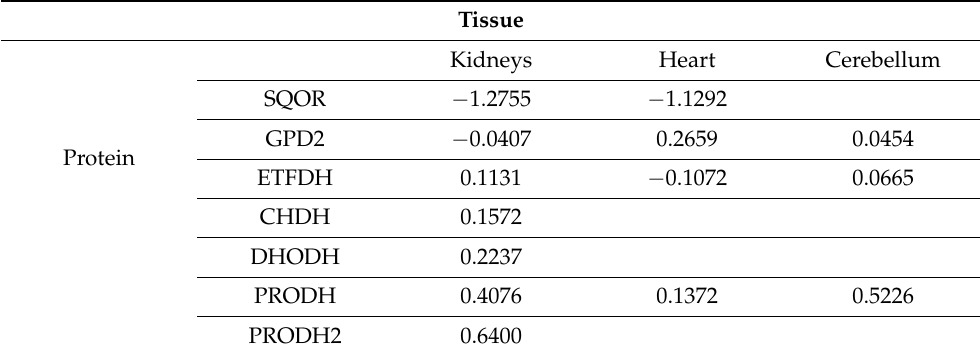
Table 1. Levels of the CoQ-linked proteins in Coq9 R239X mice compared to Coq9 +/+ mice. The values are expressed as Log 2 (Fold-Change ( Coq9 R239X / Coq9 +/+ )). Data obtained from Reference